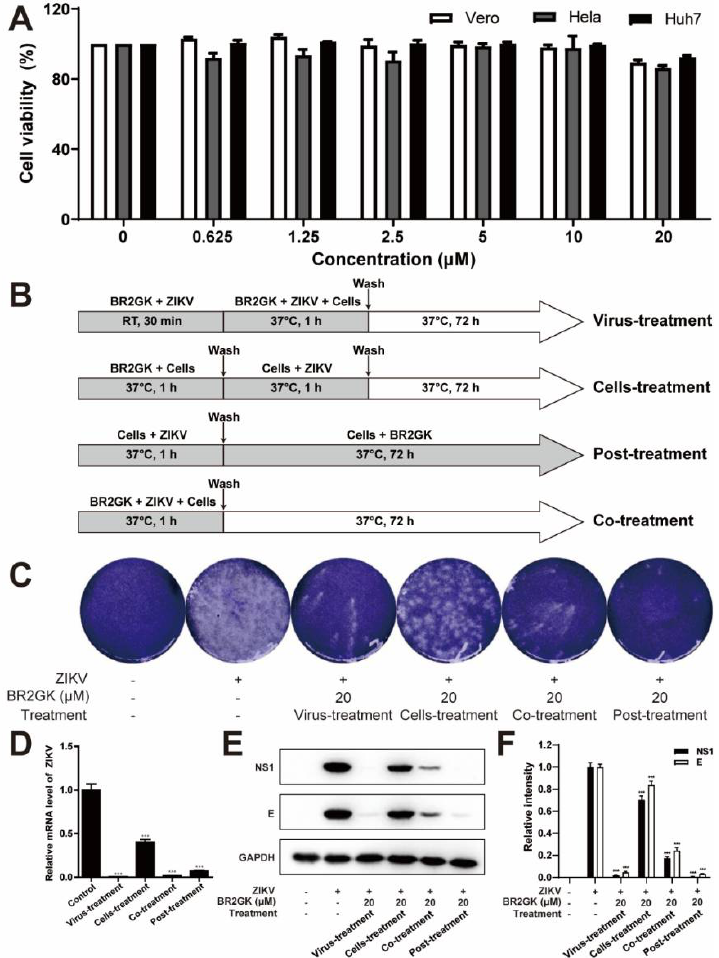
Figure 1. BR2GK inhibited ZIKV infection in vitro. ( A ) The cytotoxicity of BR2GK to Vero, Hela, and Huh7 cells within 72 h was analyzed by MTT assay. ( B ) A schematic representation of BR2GK treatment and ZIKV infection assays using Vero cells ( C – E ). Virus-treatment, cells-treatment, co-treatment, and post-treatment were used to treat Vero cells. ( C ) The extra- cellular virus content was quantified by plaque assay, ( D ) the intracellular ZIKV RNA level was detected by qRT-PCR, and ( E ) the NS1 and E protein levels were detected by Western blot. ( F ) Western blot densitometric analysis. Experimental data are expressed as mean ± SD ( n = 3), *** p < 0.001 compared with the control